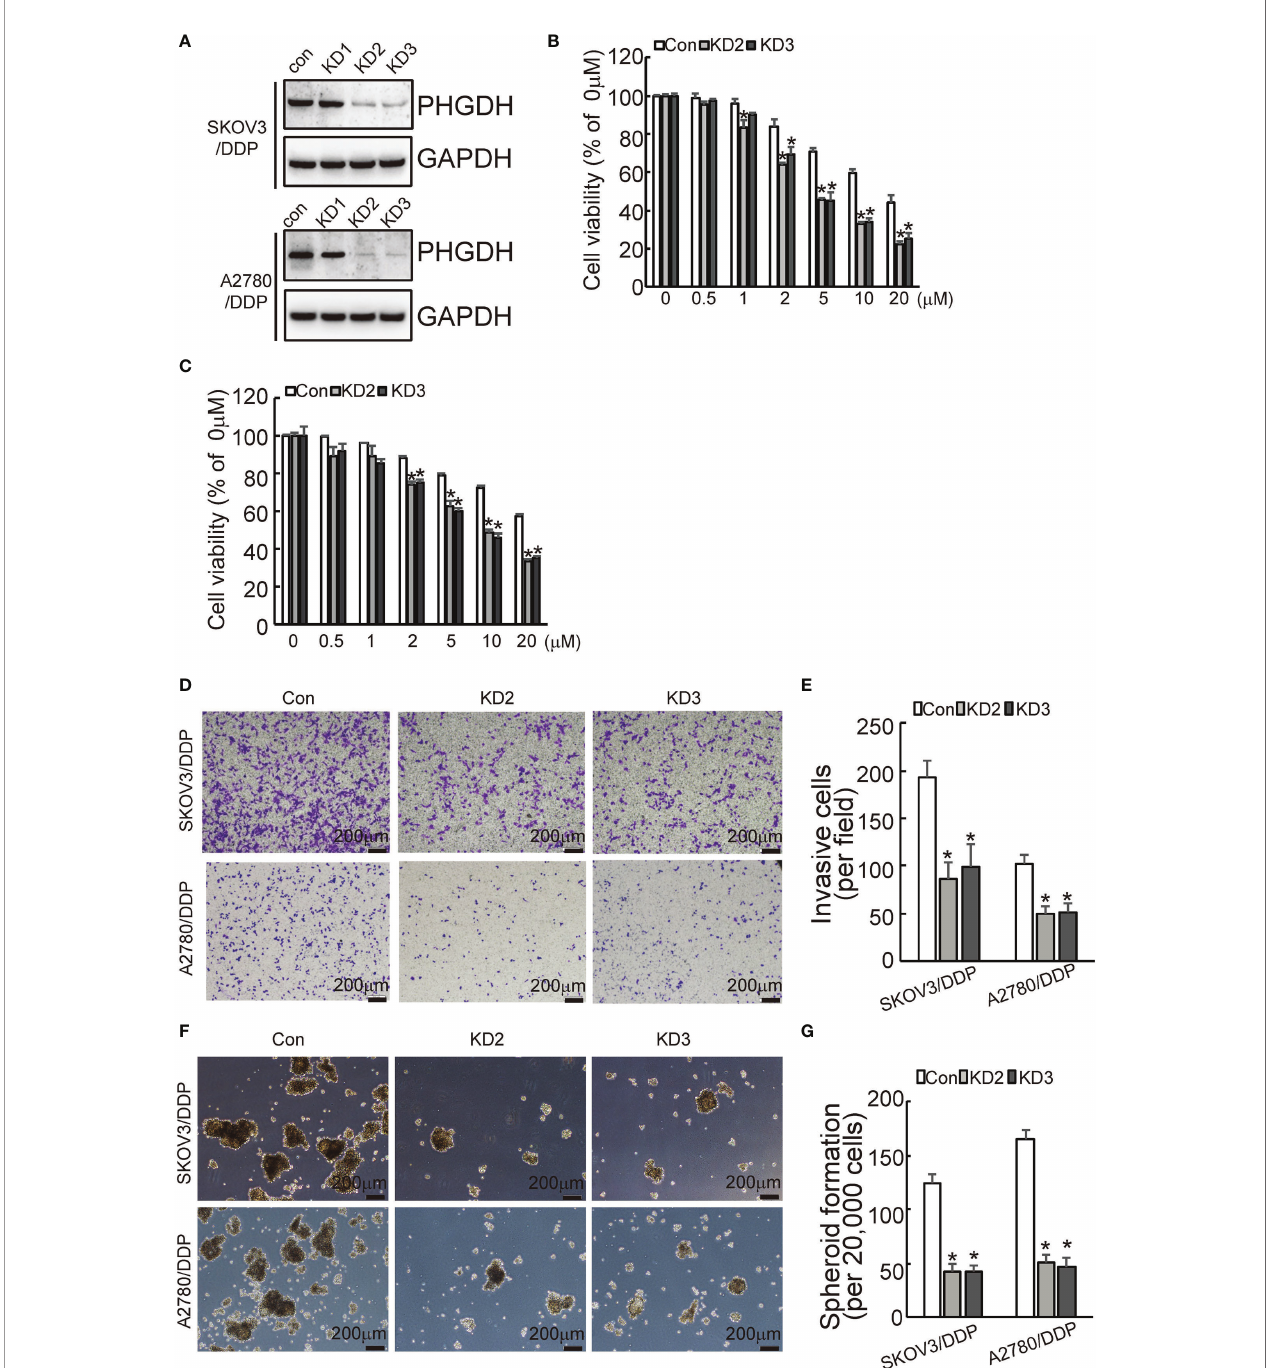
FIGURE 2 | PHGDH knockdown increases responsiveness to cisplatin and decreases capacities of invasion and spheroid formation in platin-resistant ovarian cancer. (A) SKOV3/DDP or A2780/DDP cells were infected with CASPR-Cas9 lentivirus containing speci fi c gRNA against PHGDH and the pLenti-Cas9-sgRNA-puro lentivirus vector without PHGDH targeting as control, knockdown of PHGDH was con fi rmed by Western blot. (B, C) The indicated cells were treated with the solvent control and different doses of cisplatin for 48 h, and cell viability was analyzed using CCK8 assays. (D, E) The indicated cells were plated on the Matrigel-coated transwell, invaded cells were stained with crystal violet and photographed (D) , cell numbers were counted and plotted (E) . (F, G) The indicated cells were fl oating cultured with serum-free media for 14 days, spheroid was photographed (F) , and spheroid numbers were counted and plotted (G) . * P < 0.01; N.S., not signi fi